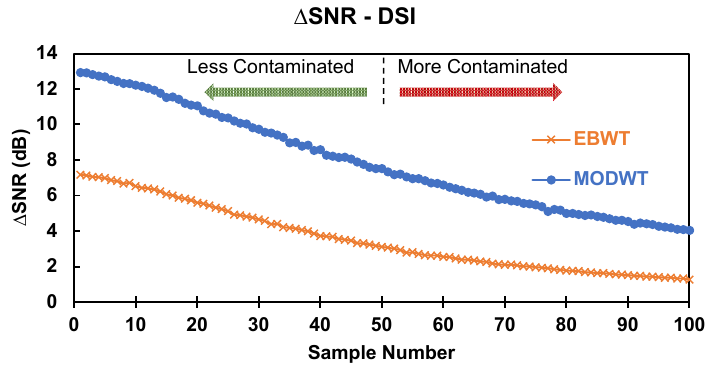
Figure 16. ∆ SNR for both the MODWT and the EBWT methods. MODWT yielded better ∆ SNR for all cases with an average of 7.89 dB, whereas the average ∆ SNR for EBWT was 3.56 dB.